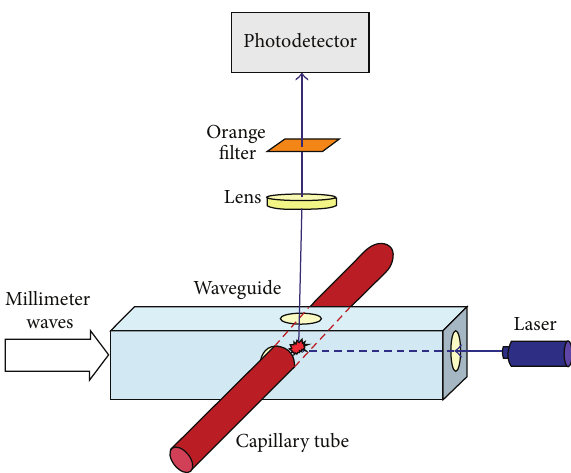
Figure 4: The measuring module is composed of laser, focusing lenses, glass capillary with a dye solution, waveguide, optical filter, and photodetector.